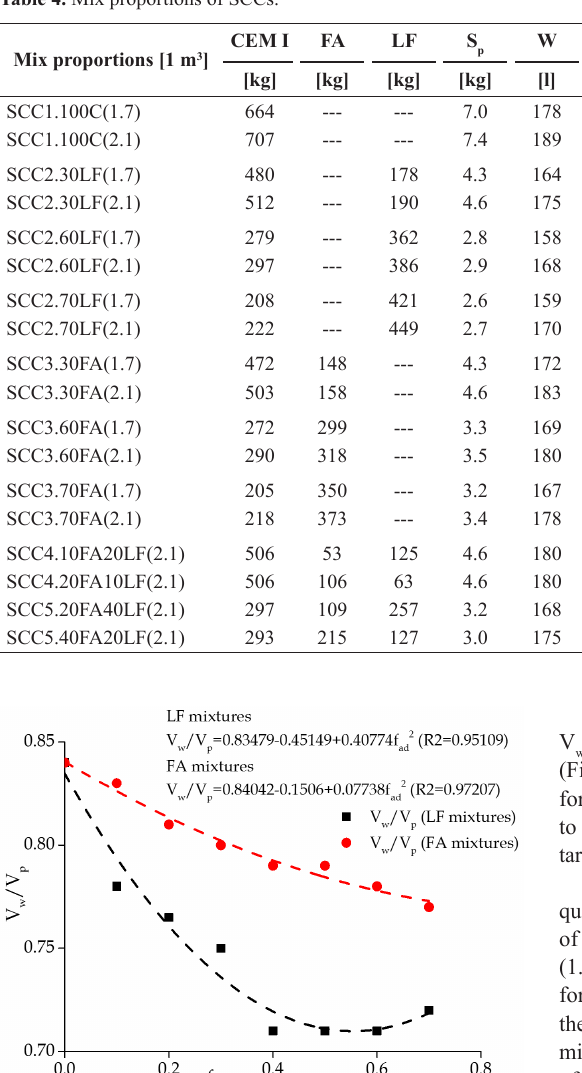
/V (ratio, in absolute volume, w p